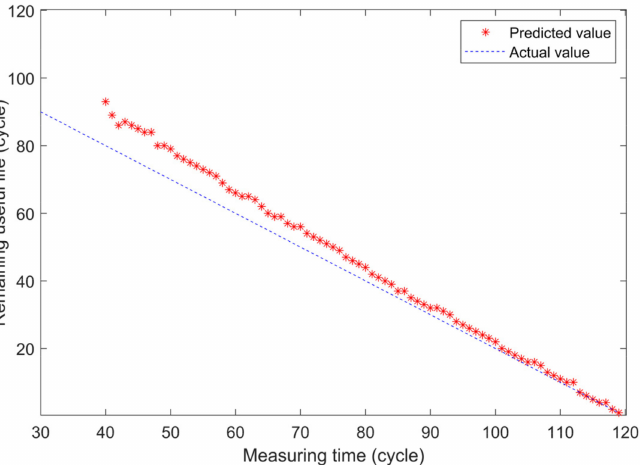
Figure 10. Predicted value and actual value of URL with variable degradation threshold.